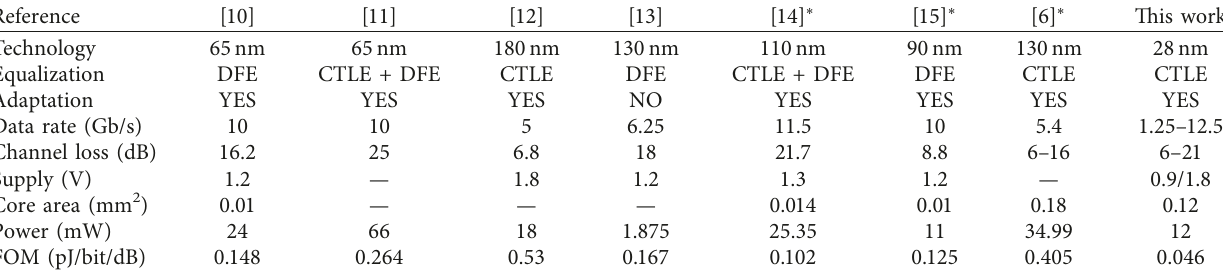
Figure 9: Postsimulation results of adaptive equalization for different data rates and channel Table 1: Performance comparison.